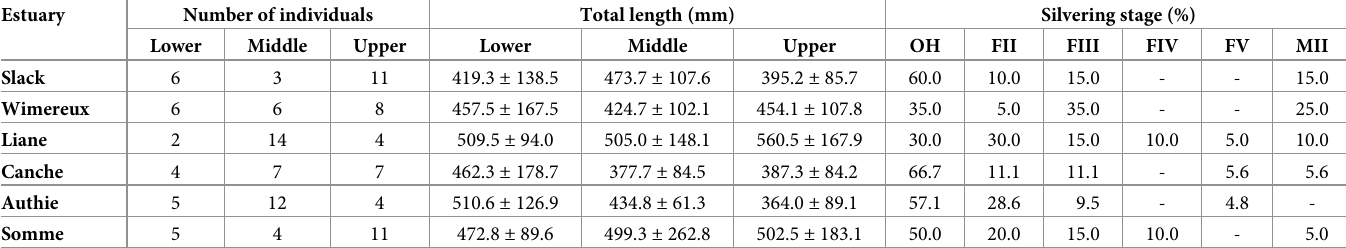
Table 1. Number of individuals analysed for gut content and stable isotope analysis along salinity gradient (i.e. lower, middle and upper) in the six estuaries, and their mean total length (mm) ± standard deviation, and percentage of individuals by silvering stages (OH growth phase, FII female growth phase, FIII female pre- migrant phase, FIV and FV female migrating phases and MII male migrating phase). Estuary